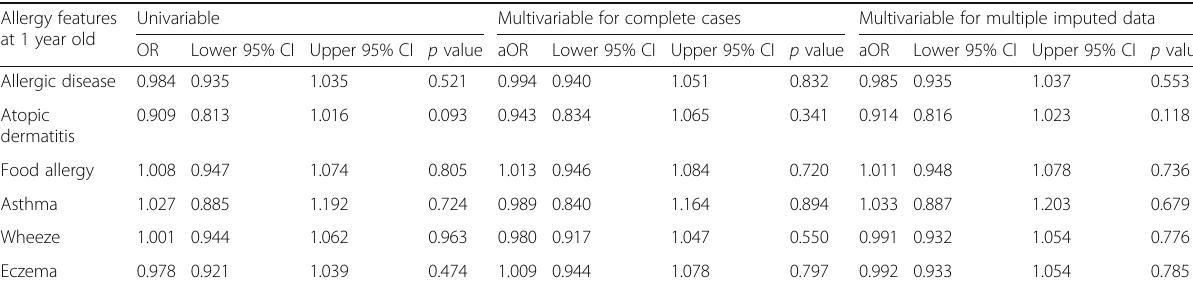
Table 1 Results of univariable and multivariable logistic regression for allergic features associated with initial inactivated vaccine compared with initial live vaccine only, in the JECS birth cohort (RQ1) Allergy features Univariable Multivariable for complete cases Multivariable for multiple imputed at 1 year old